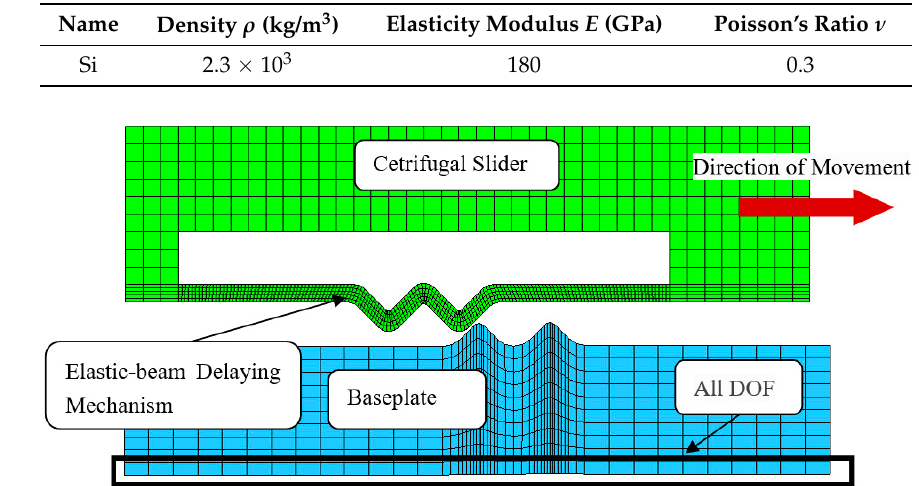
Table 3. The material properties [21].